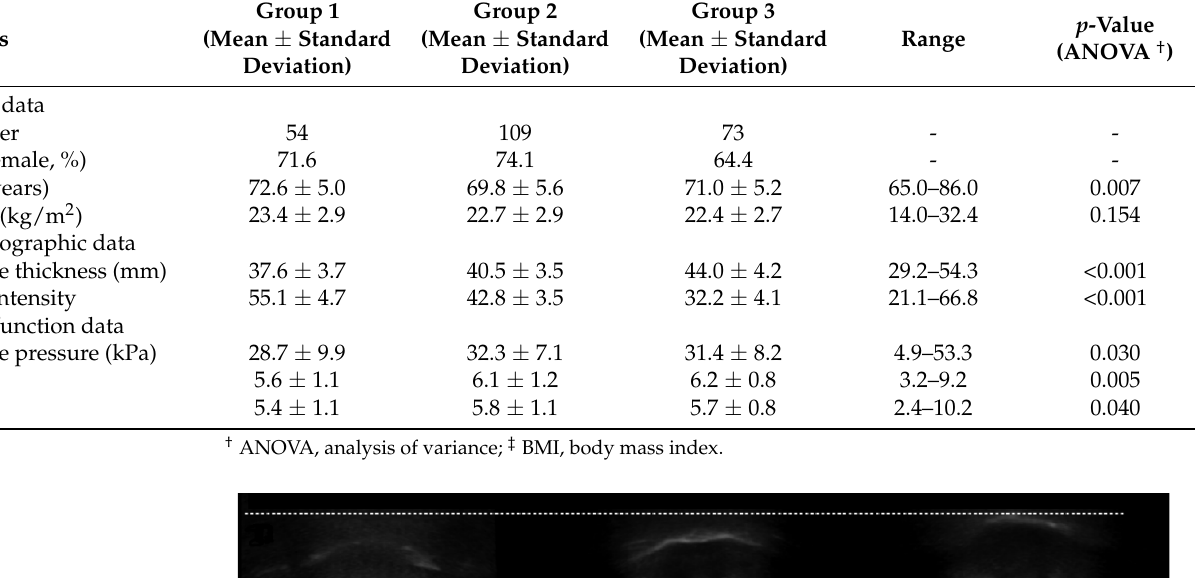
Table 1. Participant characteristics ( n = 236).